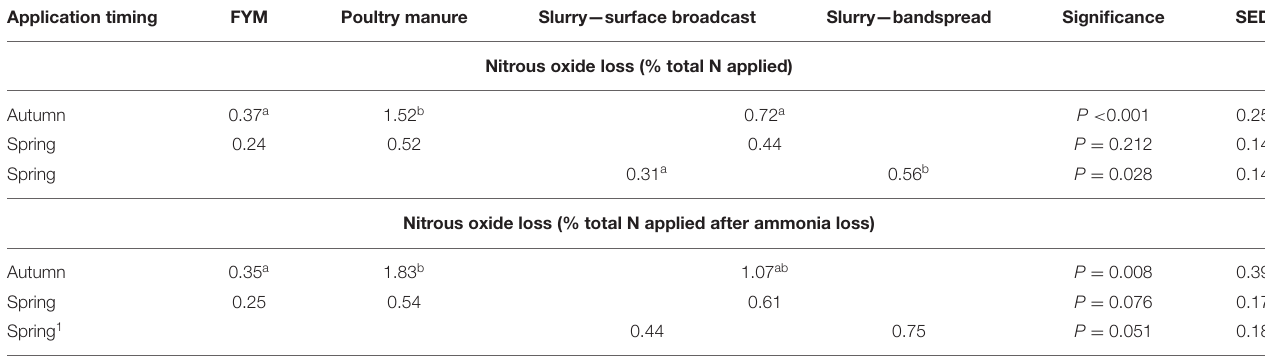
TABLE 10 | Mean direct nitrous oxide losses from the autumn and spring manure applications at the arable and grassland sites. Application timing FYM Slurry—bandspread